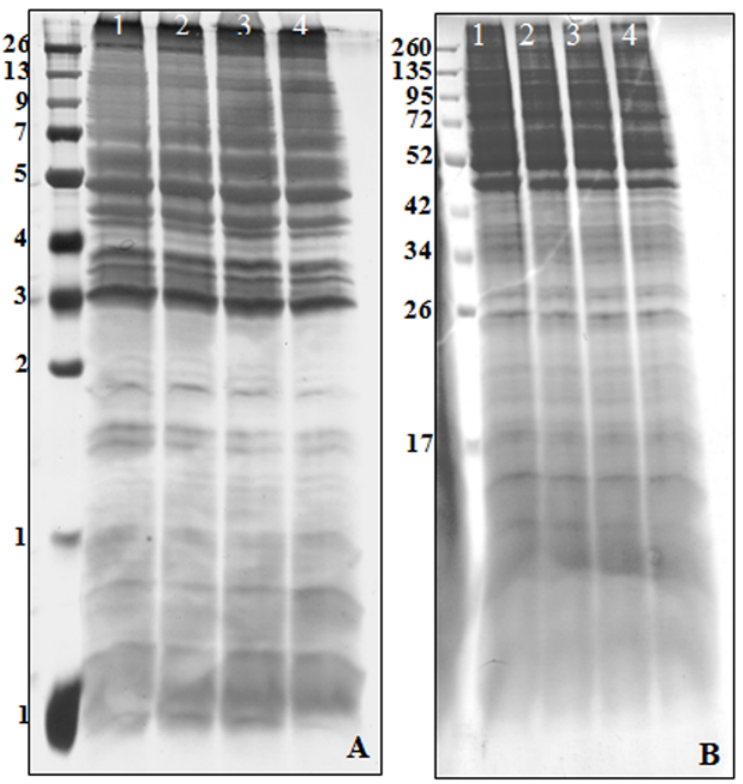
Fig 1. 1-DE profile of Toxoplasma gondii strain RH tachyzoites proteins. A. Silver stained SDS-PAGE of T . gondii RH strain tachyzoite proteins separated on 12% acrylamide slab gel (the same amount of proteins were loaded and run in lanes 1 – 4). B. Coomassie Brilliant Blue G-250 stained SDS-PAGE of T . gondii RH strain tachyzoite proteins separated on 12% acrylamide slab gel (the same amount of proteins were loaded and run in lanes 1 – 4). Molecular weight standards are shown in the left hand